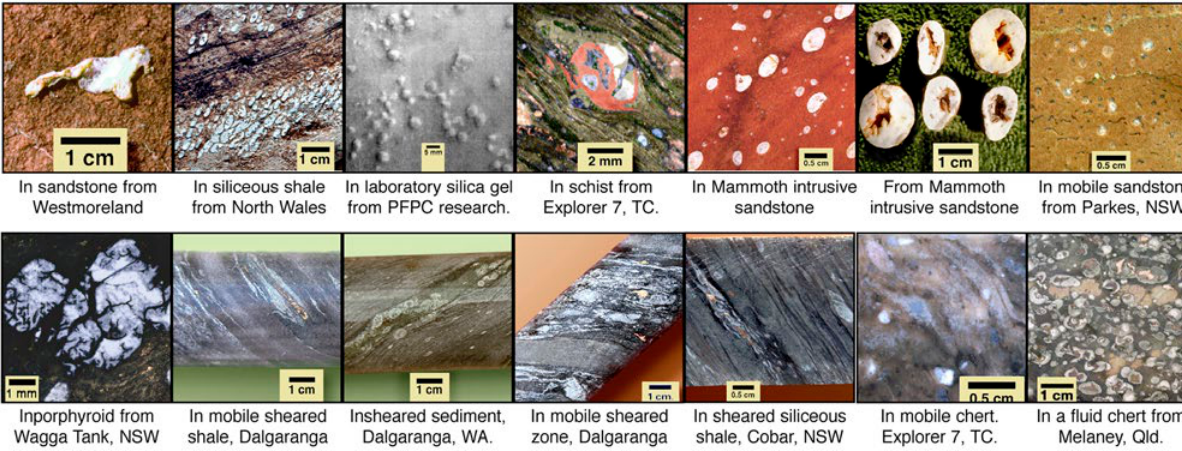
Figure 64. Fourteen examples of silica accretions developed in other locations and contexts are